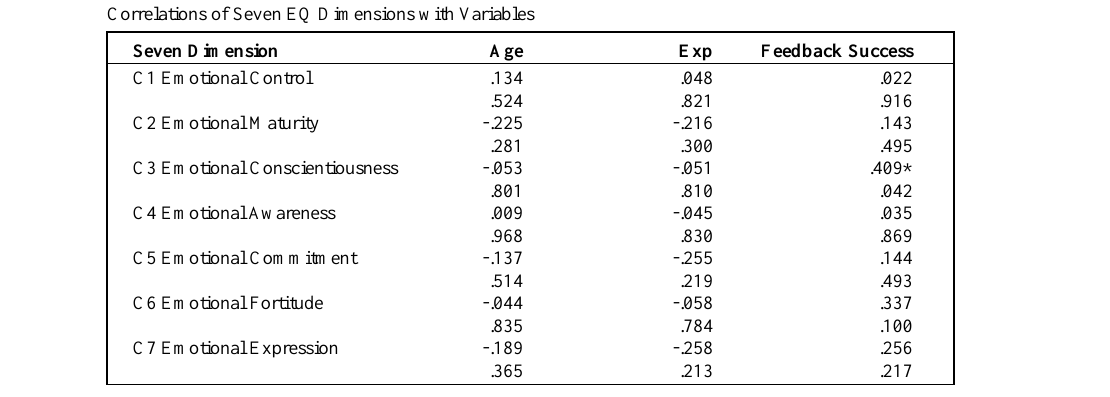
Table 4 Correlations of Seven EQ Dimensions with Variables